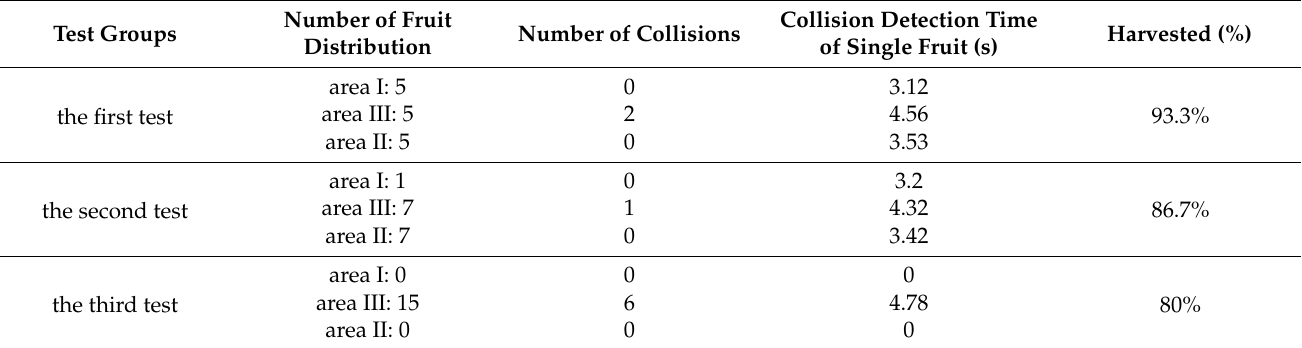
Table 7. Experimental verification